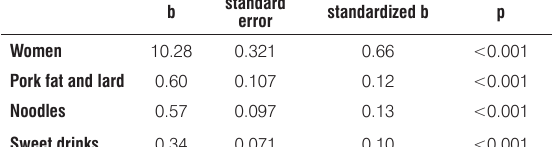
Table 8. Linear multivariable regression model for BMI depending on gender and frequency of consumed food (R 2 =0.269).